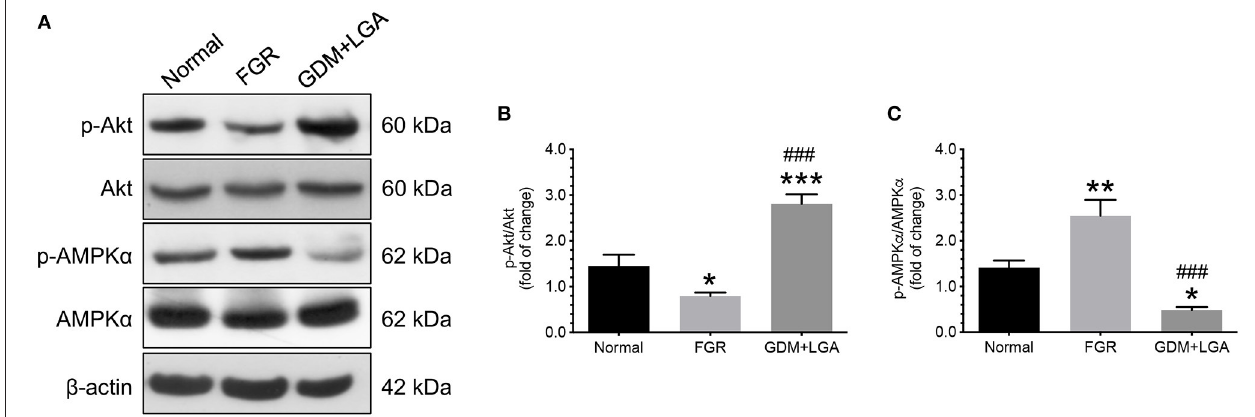
FIGURE 1 | Differential changes in the levels of phosphorylated and total forms of Akt and AMPK α in villous samples obtained from women with normal pregnancies and women with pregnancies complicated by FGR or GDM with LGA infants. Placentas from women with pregnancies complicated by FGR had a significantly lower phosphorylated to total Akt ratio but a higher phosphorylated to total AMPK α ratio compared to the placentas from normal pregnant women. In contrast, GDM women with LGA infants had a higher placental phosphorylated to total Akt ratio, but a lower phosphorylated to total AMPK α ratio than those of the women with normal pregnancies or pregnancies complicated by FGR. (A) Representative blots show the levels of phosphorylated and total forms of Akt and AMPK α . β -actin was used to normalize loading variability. (B,C) Data are presented as mean ± SEM and P values are based on one-way ANOVA followed by Tukey’s post-hoc